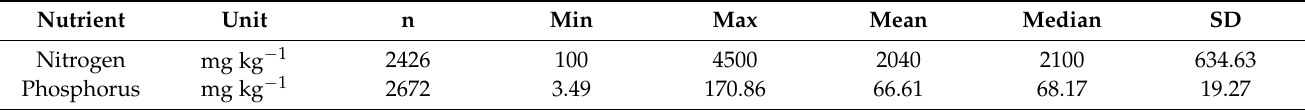
Figure 2. Some graphical results of exploratory data analysis conducted on the raw nitrogen content data: histogram ( left graph ) and normal Q-Q plot ( right graph ). Table 1. Summary statistics of nitrogen and phosphorus content measured in the sediments of Lake Balaton. Abbreviations: n: number of observations, SD: standard